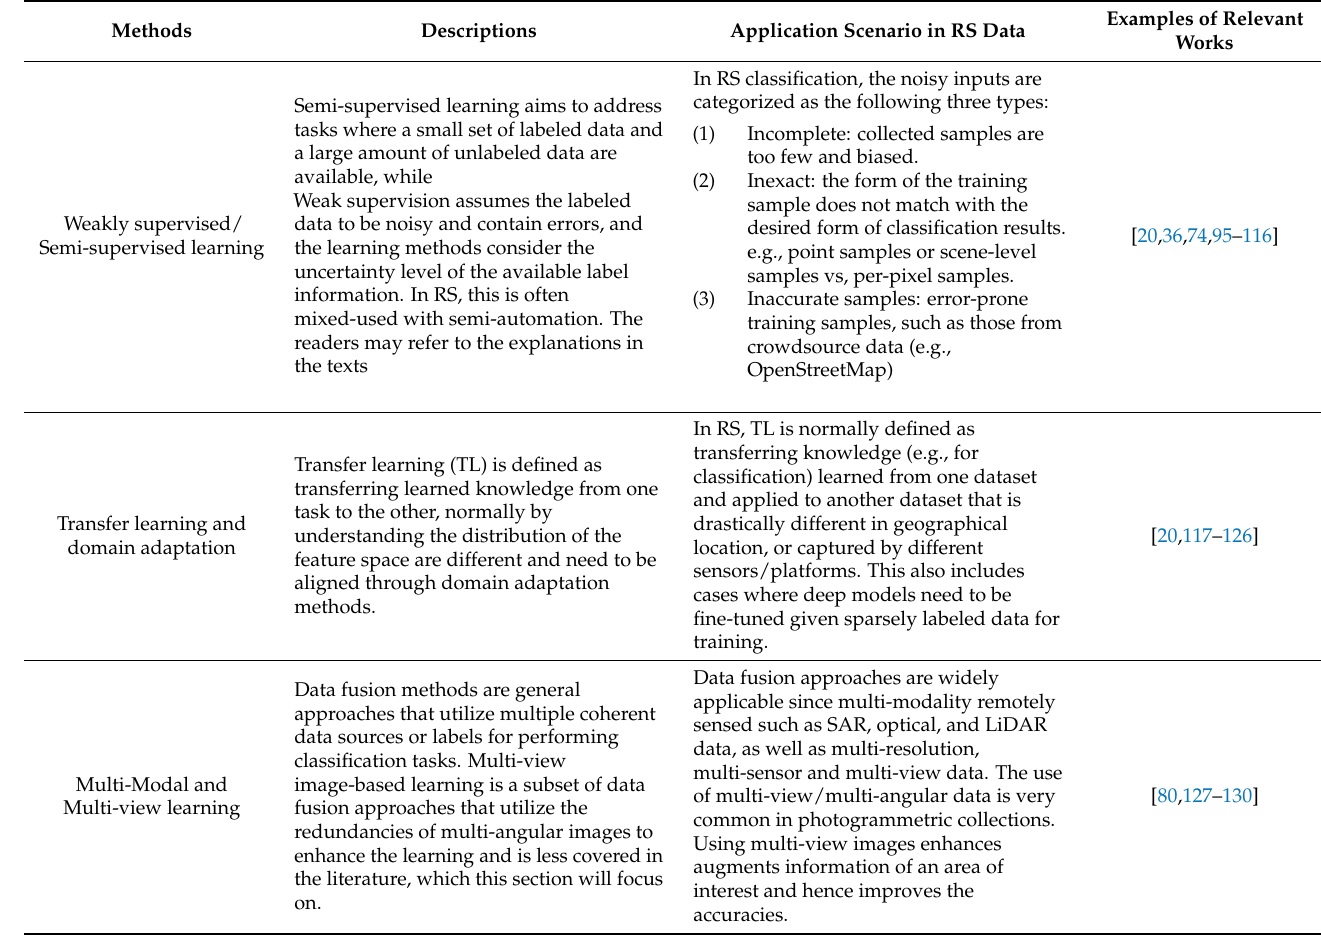
Table 1. A summary of various learning approaches addressing data sparsity and scalability chal-